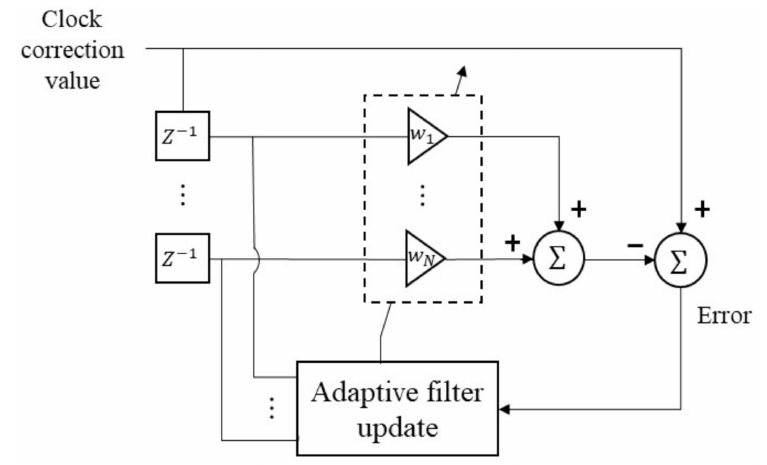
Figure 4. An example of the clock modeling